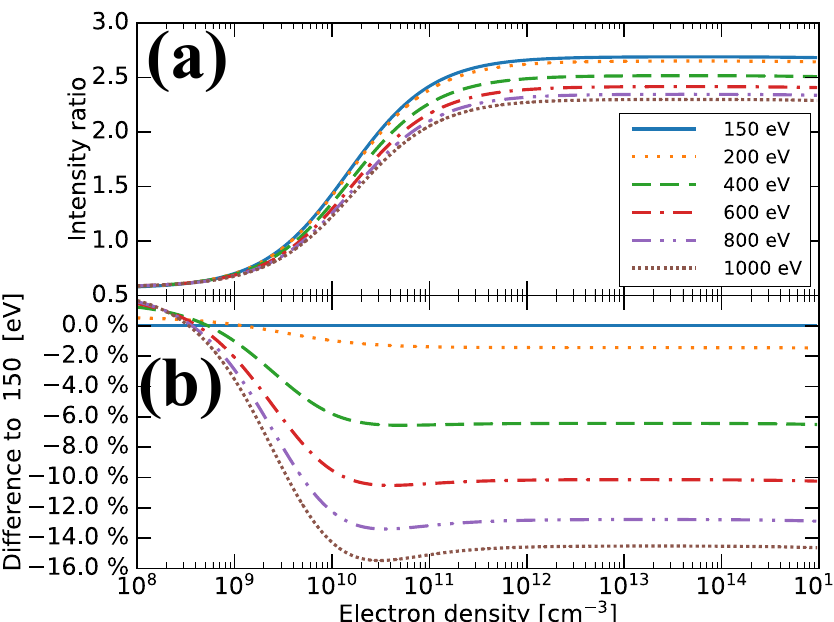
Figure 5. ( a ) Electron density dependence of Fe XIV 264.78 Å/274.203 Å intensity ratio for various temperatures for IoEx1p0 model. ( b ) Difference in intensity ratio relative to case of 150 eV at each temperature.